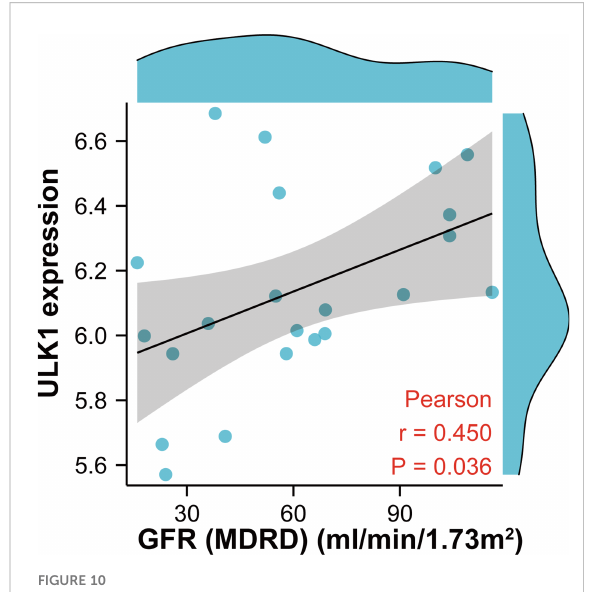
FIGURE 10 Scatter diagram indicating the relationship between ULK1 expression and renal function (glomerular fi ltration rate). Correlation analysis was assessed using Pearson